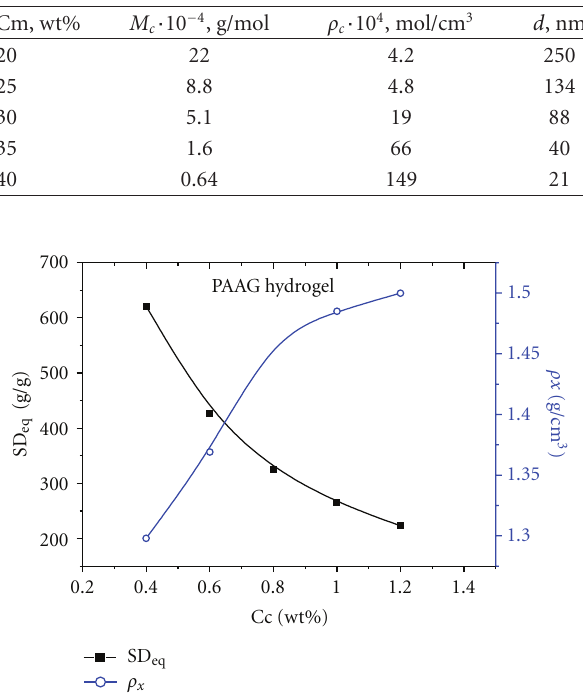
Figure 6: The e ff ects of Cc on MP of PAAG